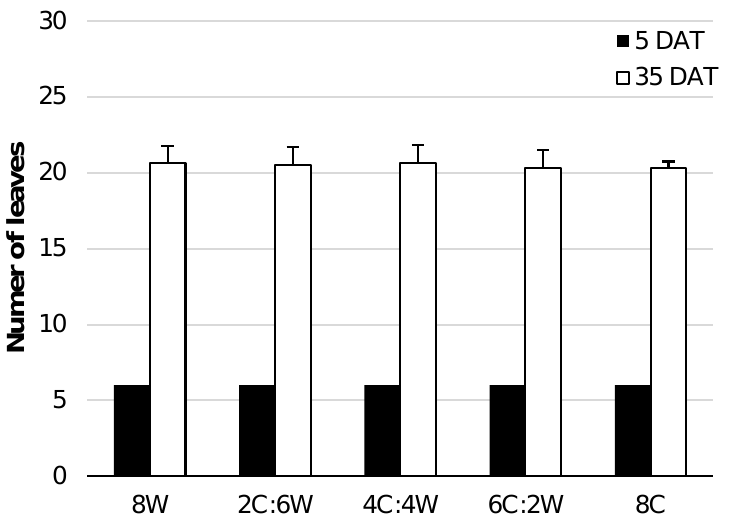
Figure 5. Number of leaves 5 and 35 DAT. Vertical bars denote standard errors of means.